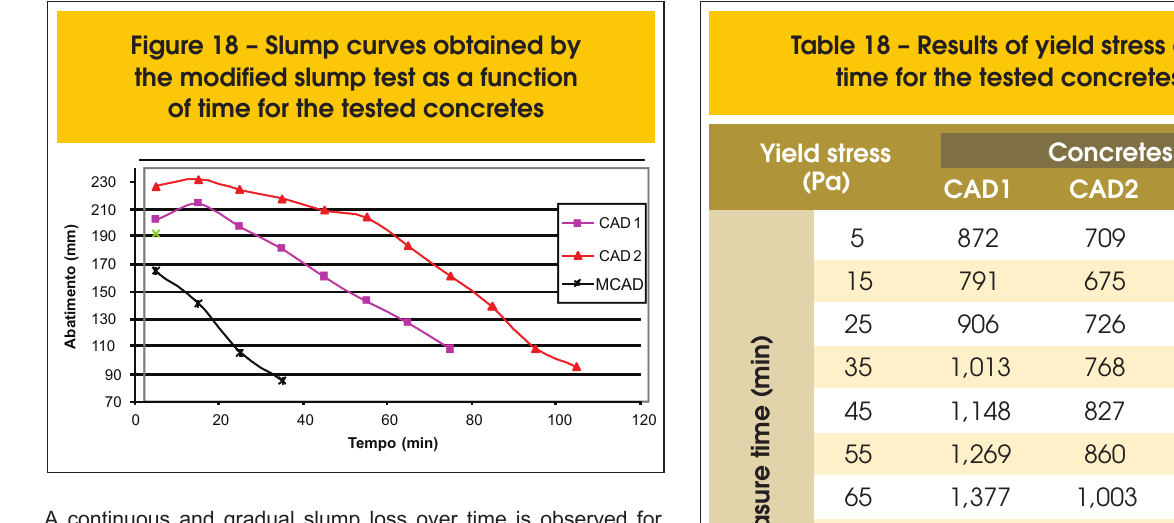
Figure 18 – Slump curves obtained by the modified slump test as a function of time for the tested concretes